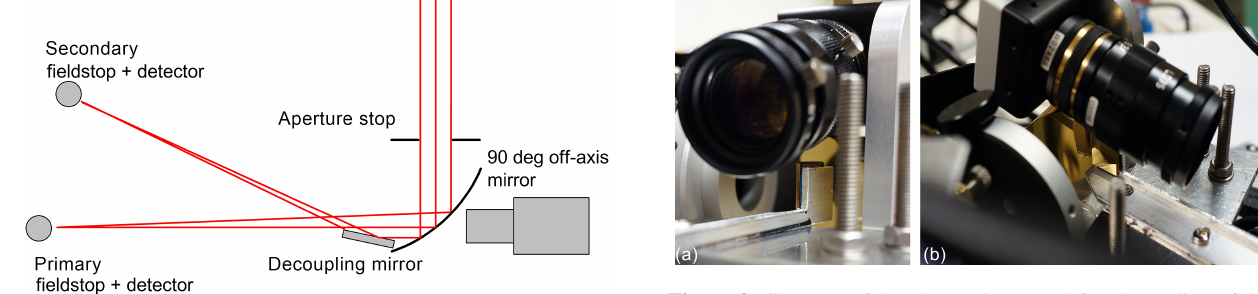
Figure 2. Close-up of the plane mirror used for decoupling of the secondary beam. (a) (left side) shows the support arm which car- ries the mirror. The mirror itself is seen from the back. On the left, parts of the circular mounting of the adjustable iris are seen. Behind the contours of the plane mirror, the larger off-axis paraboloid is lo- cated. Above the mirror, the camera used for the camera-controlled solar tracker is located. (b) (right side) offers a different perspec- tive: below the camera, the front side of the plane mirror is seen. The frame of the iris is seen from the